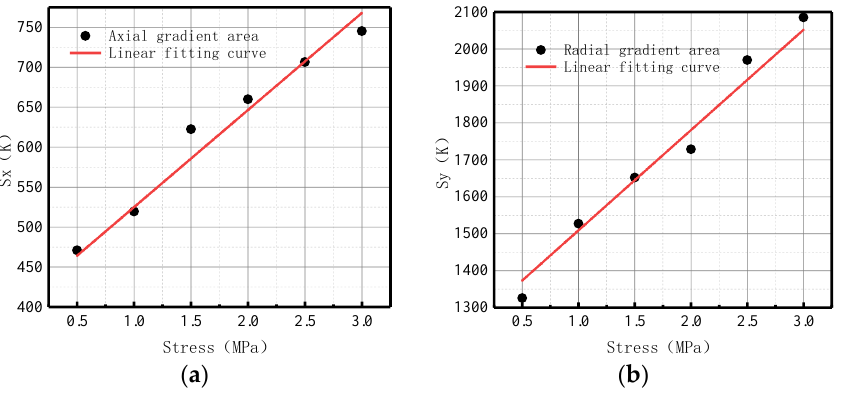
Figure 16. S ( K ) varies with the internal pressure. ( a ) Axial component of S ( K ); ( b ) radial component of S ( K ).